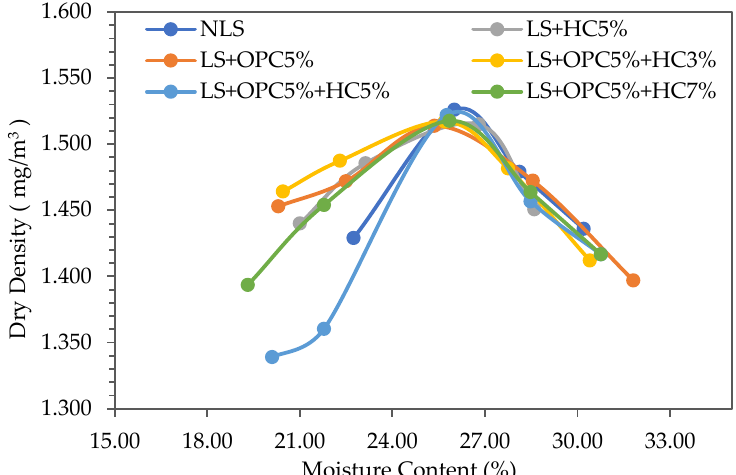
Figure 1. Result of the compaction test on the lateritic soil and cement mixed with caltite. Cation exchange causes particles to flocculate, agglomerate, and become slightly coarser, resulting in a drop in MDD. The larger and aggregated particles, which are welded together by strong interparticle connections, resist denser packing, resulting in a reduced dry unit weight. Flocculation also increased the amount of vacant space and the size of the voids, resulting in a higher water demand to fill them